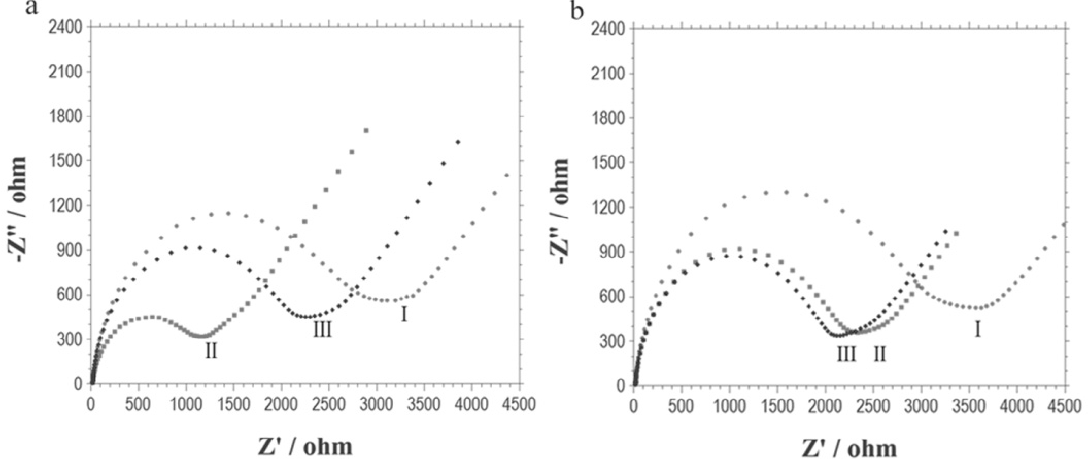
Figure 1. Electrochemical impedance spectra (Nyquist plots) of the DNA modified electrode (I) before and (II) after its incubation with ( a ) 22Rv1 cells which were treated with both 100 μ M iRGD and 50 μ M doxorubicin, or ( b ) 50 μ M doxorubicin. Curve (III) is the case of further treatment with cell lysis buffer; Test solution: 1 M KNO 5 mM Fe(CN) 63 − /4 − . Biasing potential: 0.222 V. Amplitude: 5 mV. Frequency range: 0.1 Hz to 100 kHz.